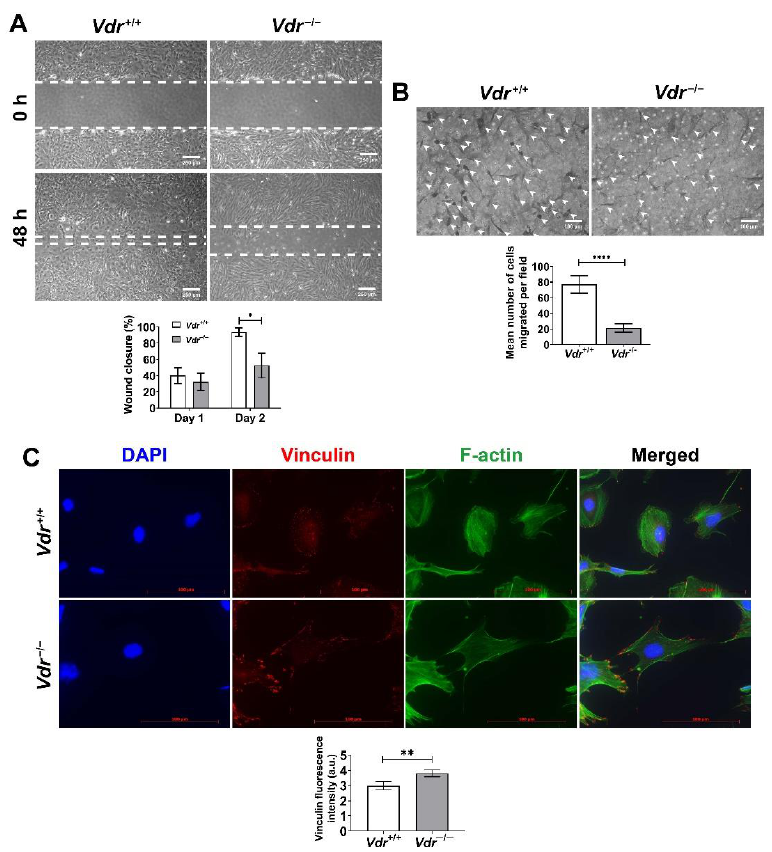
Figure 3. Vdr − / − retinal EC were less migratory. The migration of Vdr +/+ and Vdr − / − retinal EC were compared by scratch wound assay of retinal EC monolayers. Wound closure was monitored until 48 h. Using photographs of wounds ( A ) wound closure was quantitatively determined as described in Methods (n = 4, * p < 0.05). ( B ) Cell migration was also determined by performing a transwell migration assay. Cells were photographed (left panel) and the mean number of migrated cells per field were counted for quantitative analysis (n = 6, **** p < 0.0001). Arrow heads point to cells migrated through the filter and adhered to the bottom of tranwell membrane ( C ) The indirect immunofluorescence staining using phalloidin (green; actin filaments), anti-vinculin antibody (red; focal adhesions), and DAPI (blue; nuclei). Vinculin levels were determined by measuring fluorescence intensities, as described in Methods (n = 4, ** p < 0.01) .